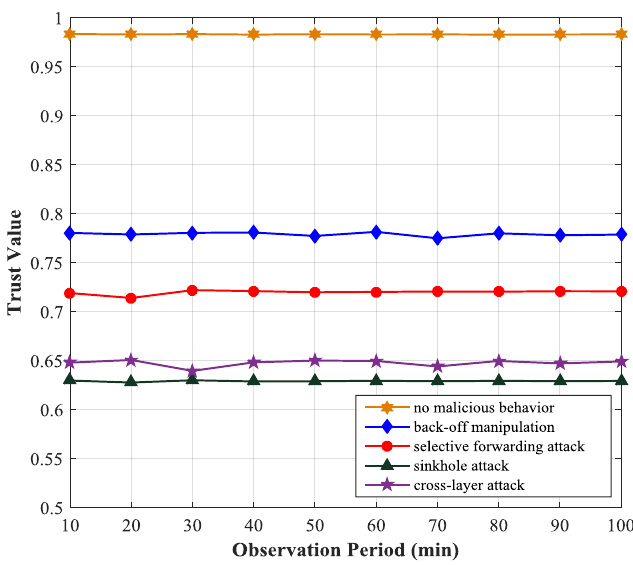
Figure 4. Trust values under different kinds of attacks.